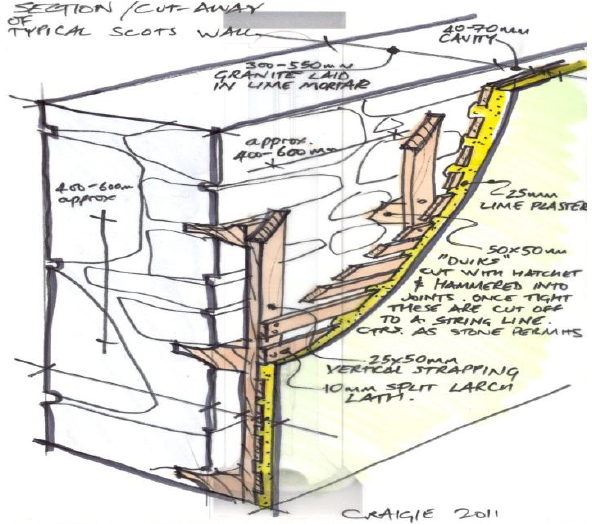
Figure 2. Illustration of wall details Owners are desperate to insulate their properties, while reticent to remove linings which form the historic fabric of the building. Existing technologies have been developed in the context of new-build construction or retro-fit to block or brick